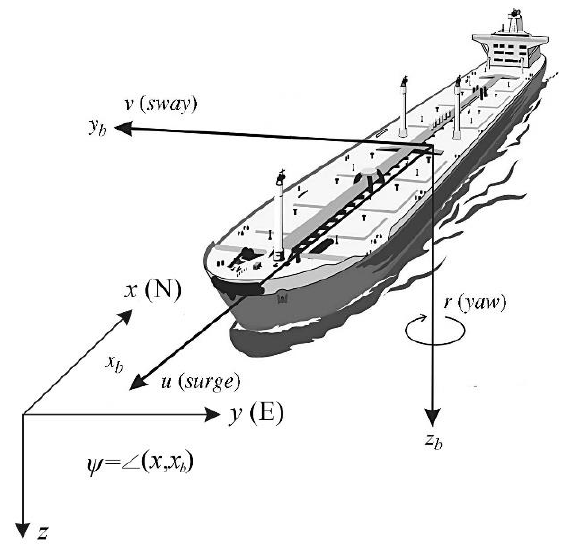
Figure 1. The earth-fixed and body-fixed coordinate systems, xy z and